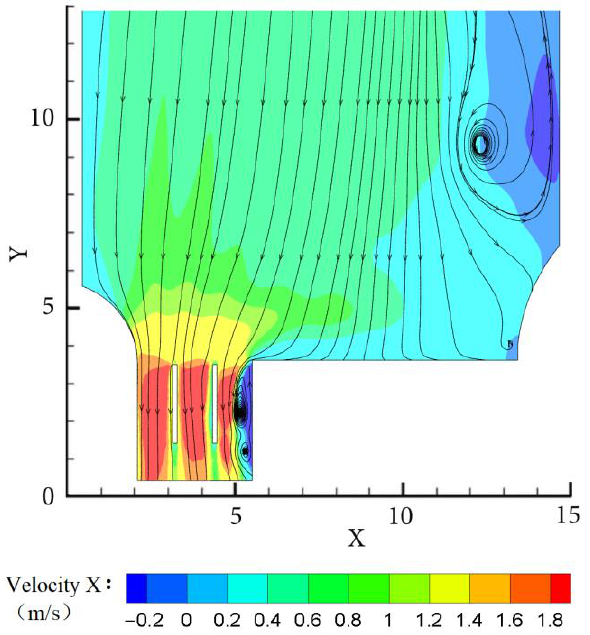
Figure 10. Flow field diagram of the superficial horizontal section (operational state of free-drain- ing).